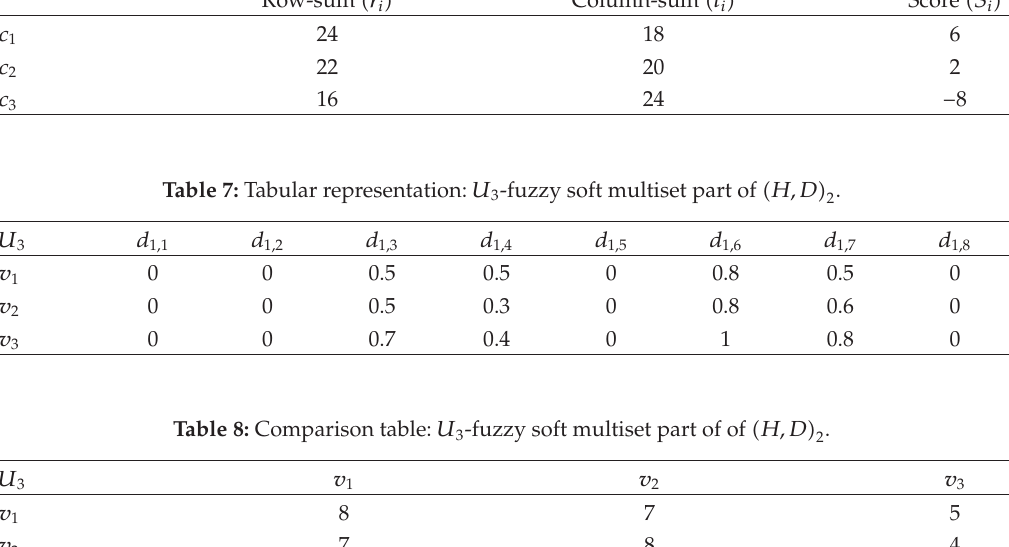
Table 6: Score table: U (cid:5) H,D (cid:6) . 2 -fuzzy soft multiset part of 1 Row-sum (cid:5) r i (cid:6) Column-sum (cid:5) t i (cid:6) Score (cid:5) S i (cid:6) c 1 24 18 6 c 2 22 20 2 − 8 c 3 16 24